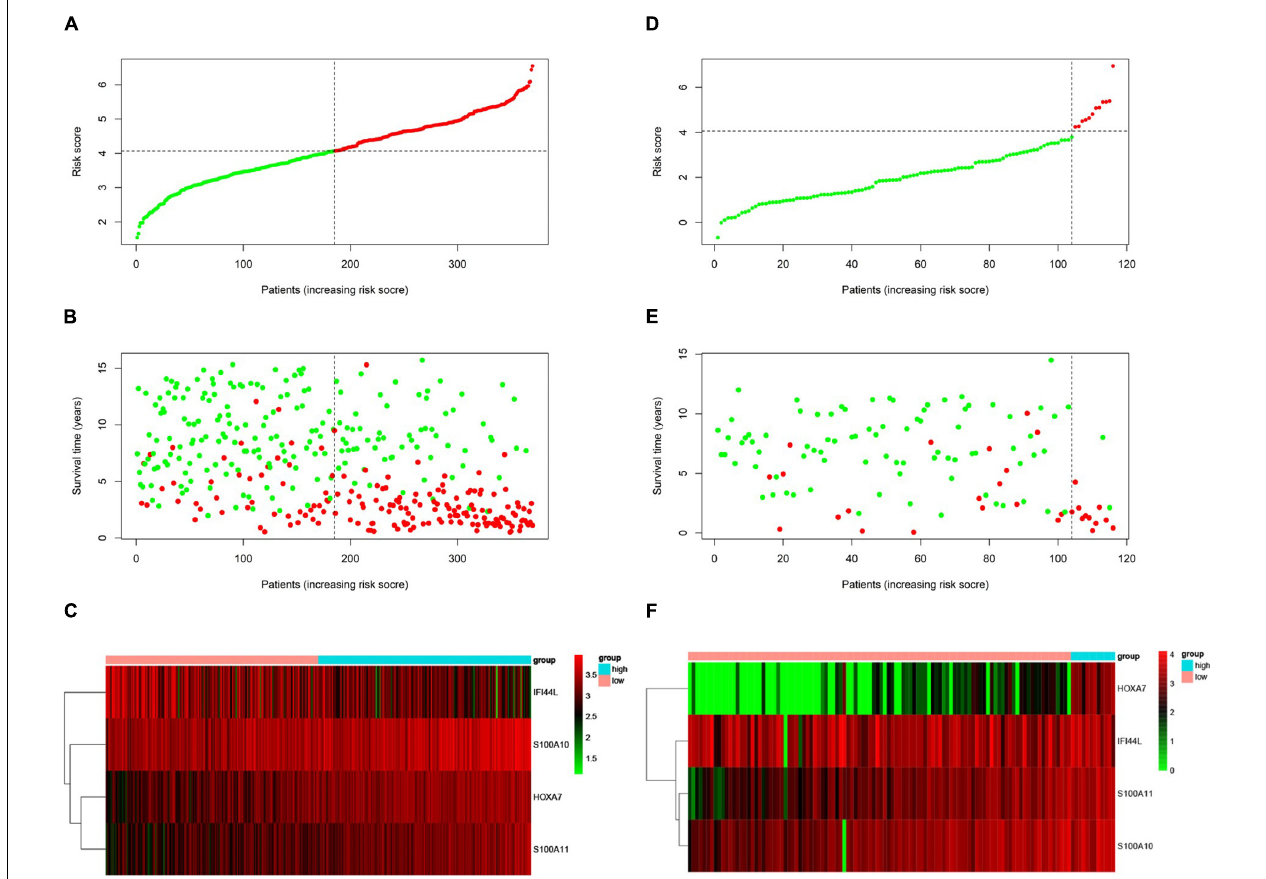
FIGURE 6 | Prognosis of high-risk and low-risk group in B-ALL patients. Risk score distribution of high-risk (red) and low-risk (green) group in B-ALL patients from Total Set (A) and External Validation Set (D) . Scatter plots show survival status in Total Set (B) and External Validation Set (E) , red plots represent dead and green plots represent alive. Heatmap of the expression profiles of the four prognostic genes in low- and high-risk group in Total Set (C) and External Validation Set (F) .